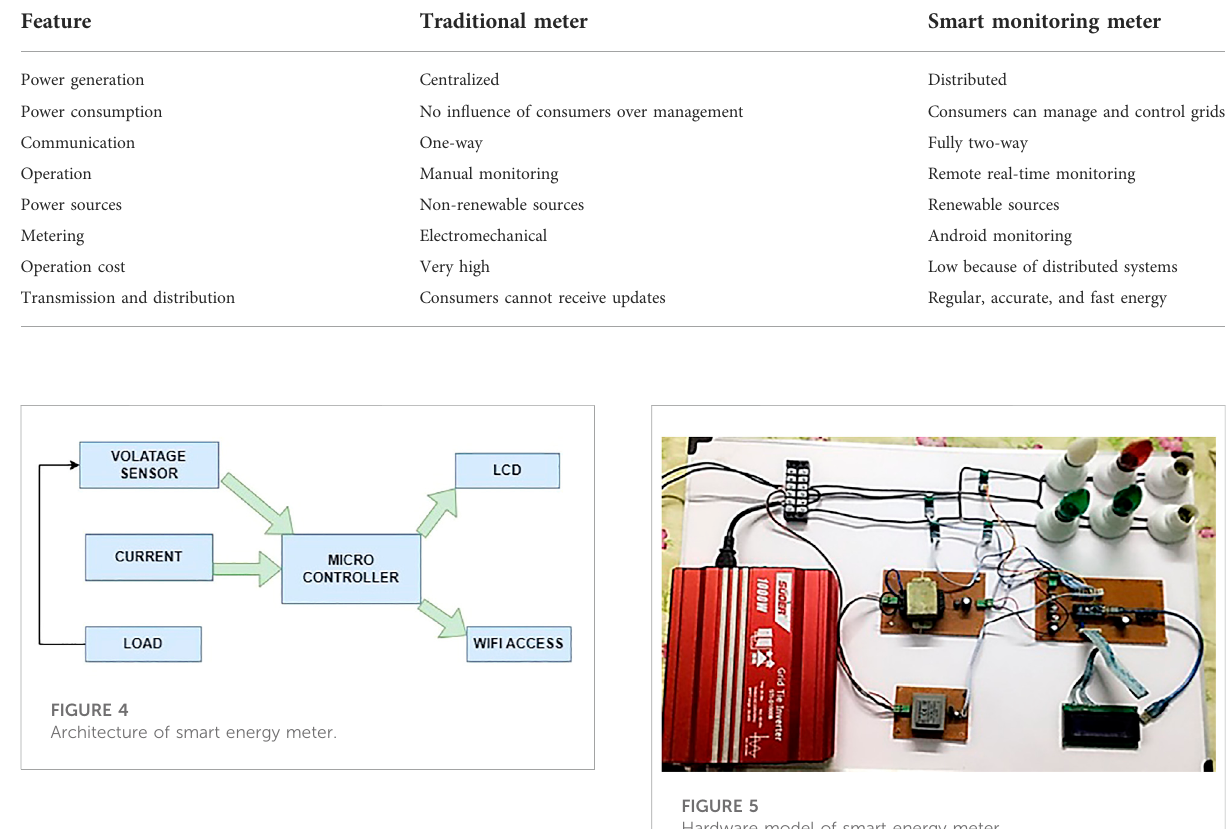
TABLE 2 Differences between traditional meters and smart monitoring meters.